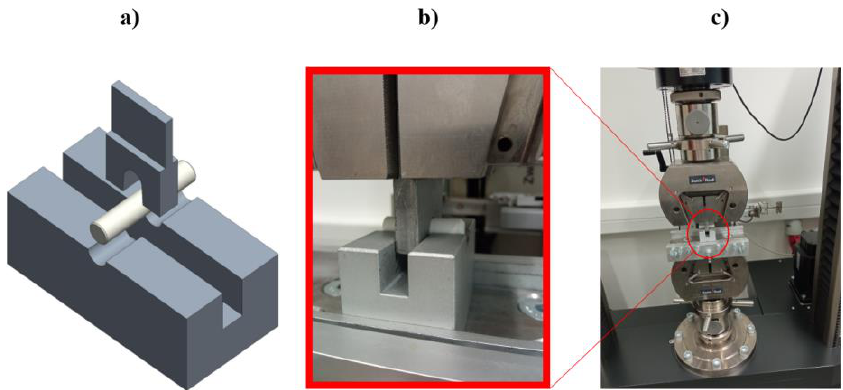
Figure 2. Test arrangement for the double shear test: ( a ) CAD model, ( b ) close view, ( c ) installed in the measuring machine.